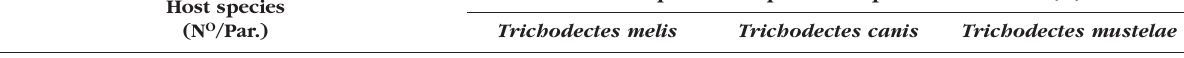
Host species (N O /Par.)